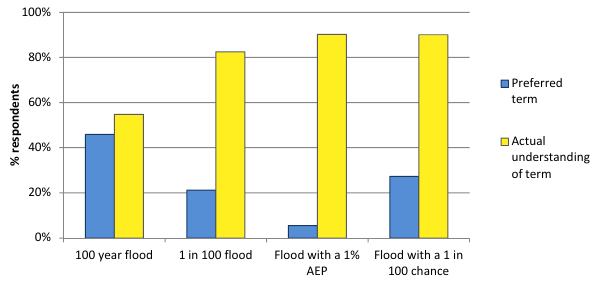
Fig. 6. Difference between preferred terminology and actual under- standing of that term in Ireland ( n = 366; non-response=70).